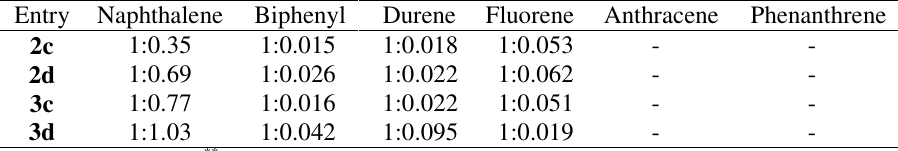
Table 2. Stoichiometric ratio (stoichiometry of tweezer: arene complex)